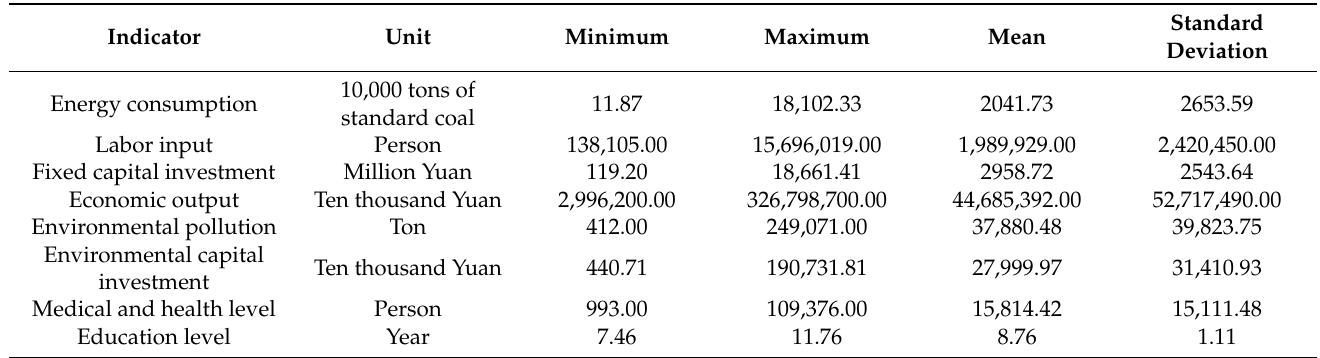
Table 1. The descriptive statistical analysis of indicator data.